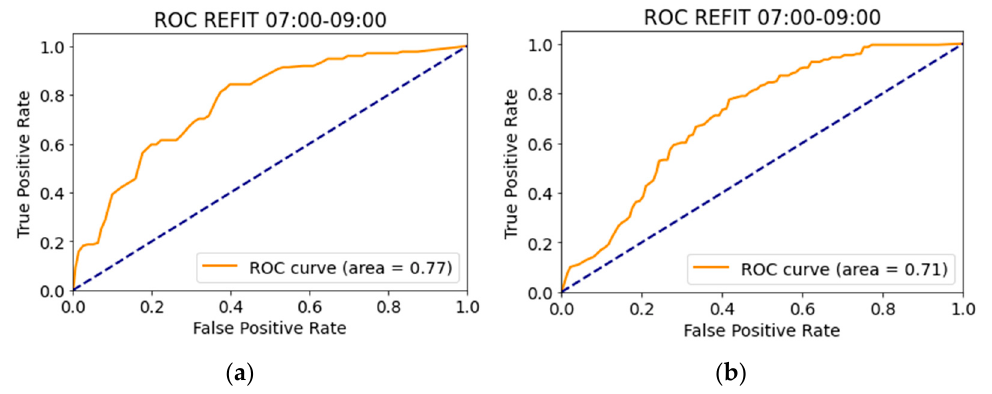
Figure 2. ROC curve examples for DR scenarios concerning ( a ) dish washers ( b ) Tumble Dryers.